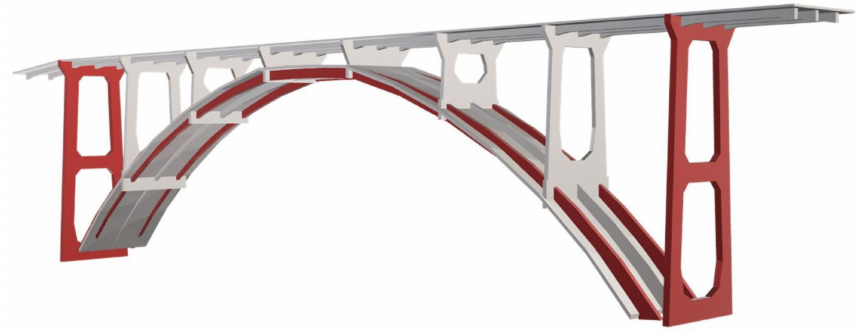
Figure 3. Scheme of the bridge with the monitored members highlighted in